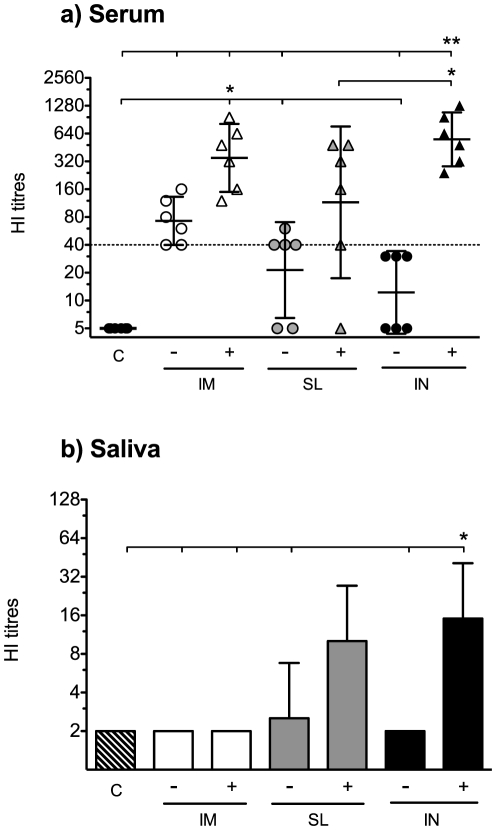
The c-di-GMP adjuvanted vaccine induced both systemic and local haemagglutination inhibition responses when administered mucosally.Haemagglutination inhibition (HI) antibodies were measured at day 42 in a) serum. The data show the response of each individual mouse and the geometric mean titres ±95% confidence interval. The dotted line represents an HI titre of 40. b) The local HI response was measured in saliva at day 42 after intraperitoneal injection of pilocarpine and collection of saliva. To obtain enough sample volume, the salivary HI assay was conducted on pooled saliva samples. The data show the geometric mean titres +95% confidence interval of three independent experiments. * and ** indicate statistically significant differences between groups (p<0.05 and 0.01 respectively, One-way ANOVA with Bonferroni's correction for multiple group comparison). The mice (six per group) were vaccinated with the virosomal H5N1 vaccine (NIBRG-14) alone (−) or in combination with (+) c-di-GMP adjuvant by the intramuscular (IM), sublingual (SL) or intranasal (IN) route. One additional group received a mock vaccine (C) of c-di-GMP administered alone by the IN route.